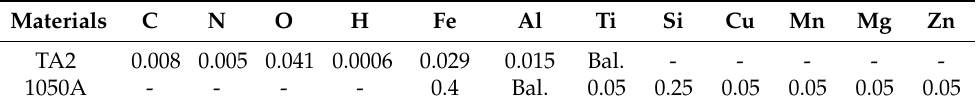
Table 1. Chemical compositions of materials (Mass